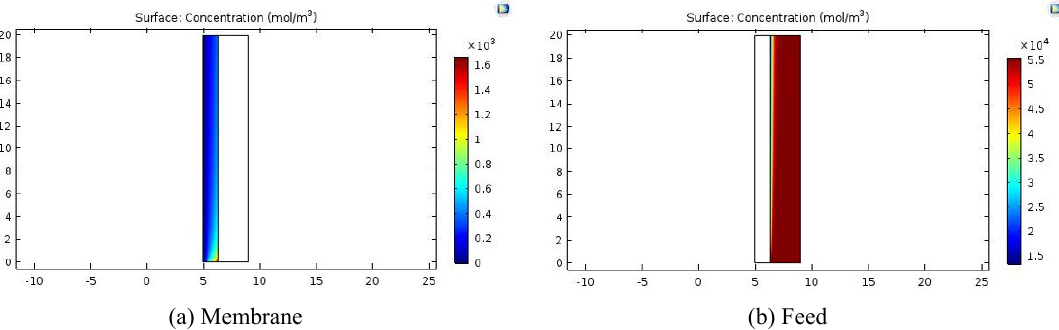
Fig. 7: Concentration distribution of water at 60 °C temperature and 3 l/min feed flow rate (1 bar); (a) Membrane section and (b) Feed section